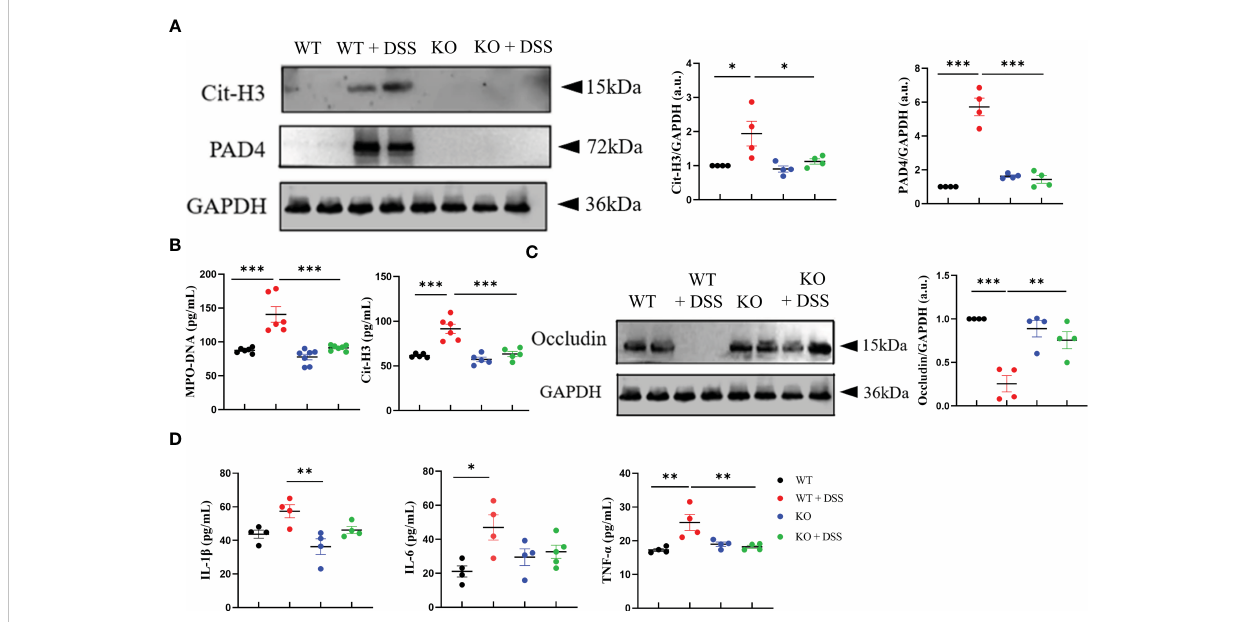
FIGURE 6 PAD4 de fi ciency improved intestinal integrity and alleviated intestinal in fl ammation in chronic colitis mice. (A) Western blot analysis of Cit-H3 and PAD4 in colon tissue (n=4). (B) The level of MPO-DNA and Cit-H3 in serum (n=6). (C) Western blot analysis of Occludin in colon tissue (n=4).